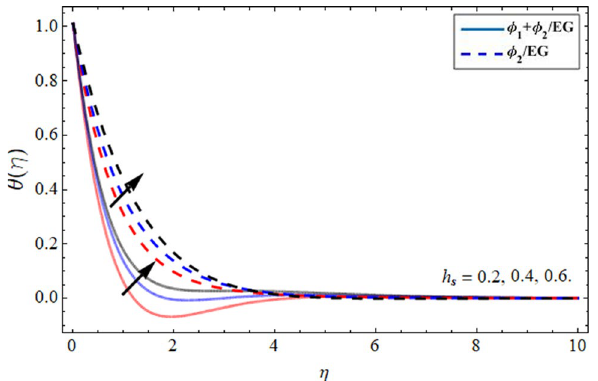
Figure 11. Energy θ(η) outlines versus the effect of heat generation term h s .